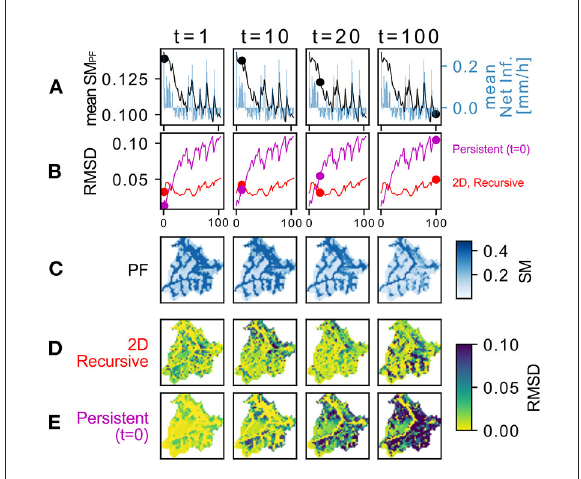
FIGURE4 Comparison of soil moisture predictions with the trained 2D CNN and persistence from the peak soil moisture. (A) shows the timeseries of domain average soil moisture as simulated by ParFlow-CLM since the peak soil moisture of Water Year and the corresponding net infiltration (qflx_infl - qflx_tran_veg ParFlow-CLM variables). In (B) , the timeseries of Root Mean Squared Differences for the 2D CNN model and the persistent case, in which the 2D soil moisture at the peak is just assumed to remain constant throughout the rest of the year. The markers in (A,B) highlight the time of the snapshot (columns), as reported on top of the figure. In (C) , the snapshots of ParFlow-CLM soil moisture fields at the different time steps, and in (D,E) , the corresponding RMSD maps for the 2D CNN ( 2D Recursive ) and assuming soil moisture does not change in time ( Persistent (t=0) , soil moisture is assumed to remain constant as on the day of the peak soil